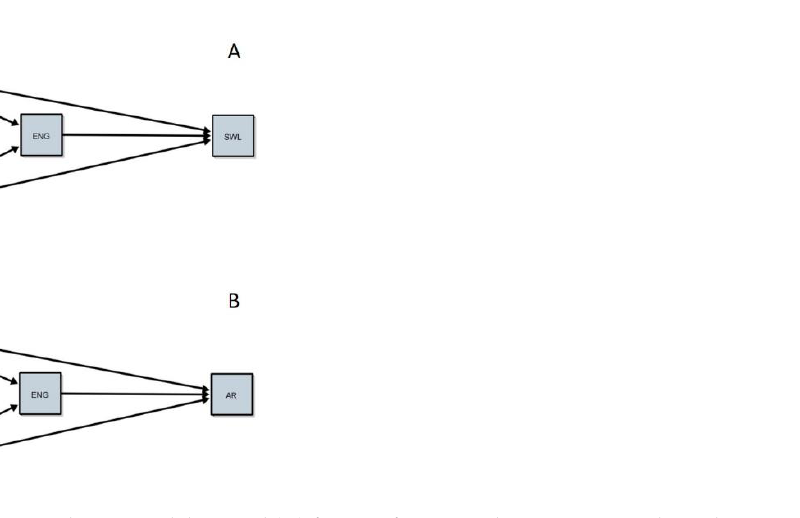
Figure 1. Mediational SEM models. Panel ( A ) for Satisfaction with Live as VD and Academic Record for Panel ( B ). EI = Emotional intelligent; RES = Resilience; ENG = Engagement; SWL = Satisfaction with Life; AR = Academic Record.